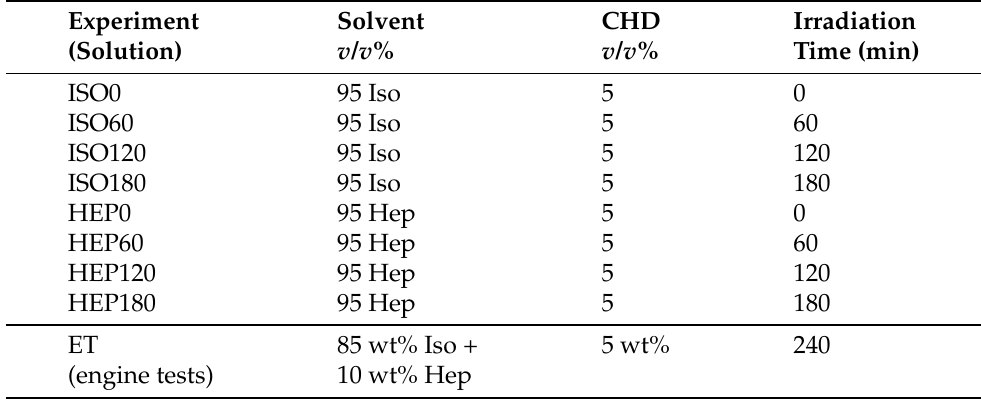
Table 1. Overview of the fuel solutions